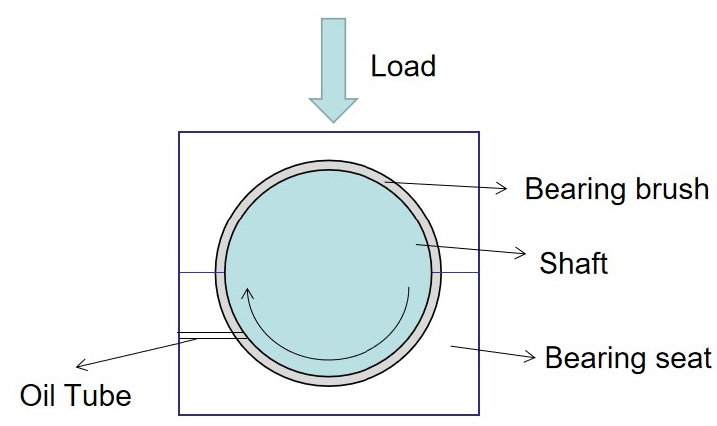
Figure 4. Schematic diagram of the testing machine.